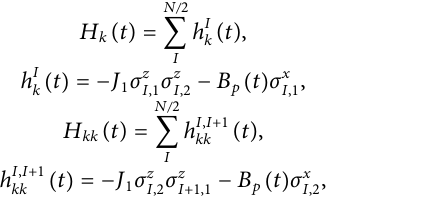
respectively. Here the coef fi cient 1 . 835 4 2D Ising model described in the following text.